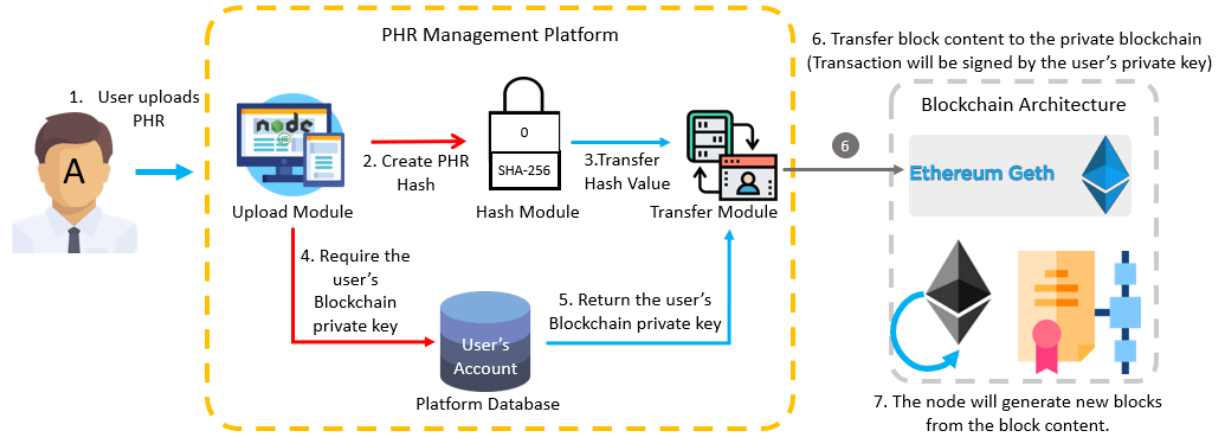
Figure 3. Block creation process. PHR: personal health